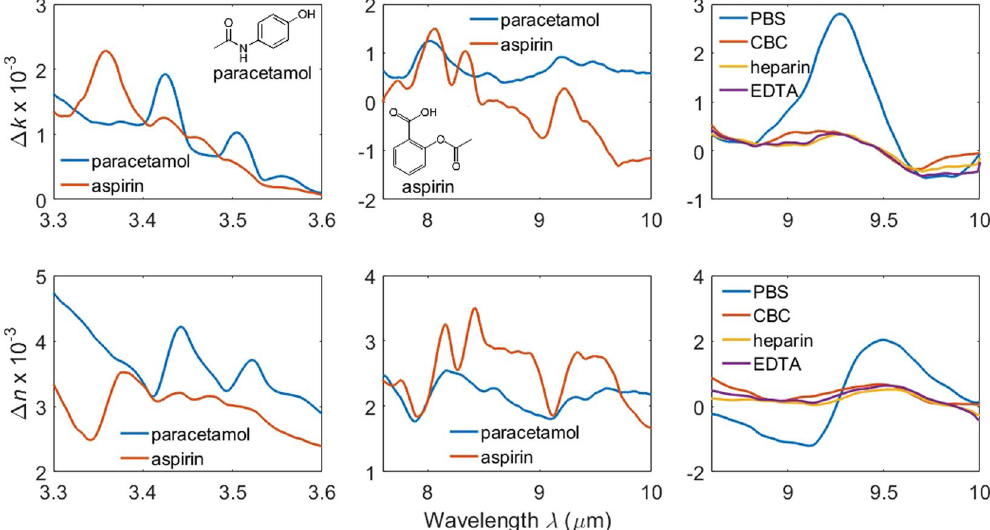
Figure 7. Change in the imaginary (top row) and real (bottom row) parts of refractive index for all the aqueous solutions with respect to water. Each column shows a different wavelength region of interest: the first two columns for the analgesics, and the third column for the anticoagulants and buffers. The molecular structures of paracetamol and aspirin are shown